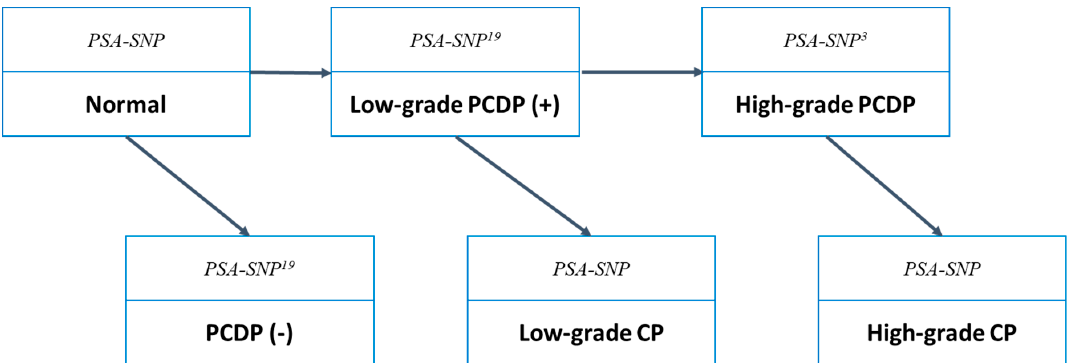
Figure 1. Gene-prostate-specific-antigen (PSA)-based six-state model for non-progression and progression of low-grade and high-grade prostate cancer (PrCa). * The superscript numbers beside SNP indicate the number of SNPs used in the transition risk. CP: clinical phase; PCDP: preclinical detectable phase.